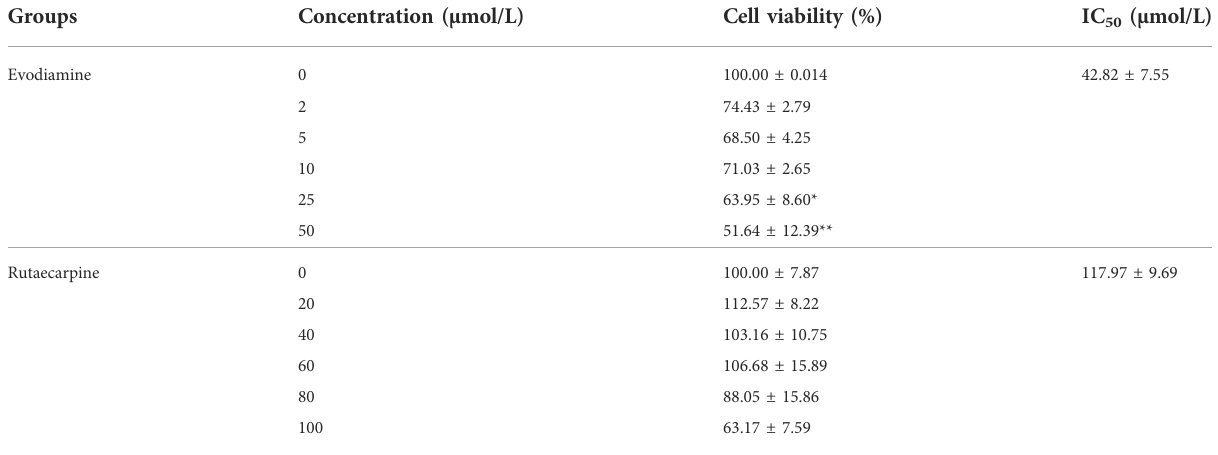
TABLE 1 Cell viability assay and IC 50 of evodiamine and rutaecarpine ( n = 6, ‾ x ± s ).